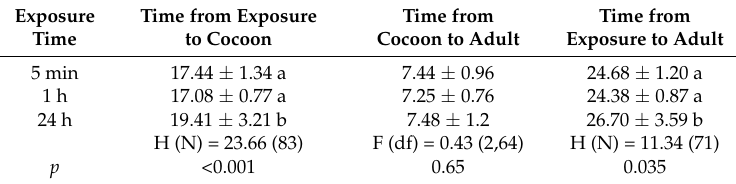
Table 2. Development times in days (mean ± SE) of D. coccinellae in H. axyridis : (I) from exposure to parasitoid cocoon detection; (II) from parasitoid cocoon detection to adult emergence; (III) from exposure to parasitoid adult emergence (total development time).